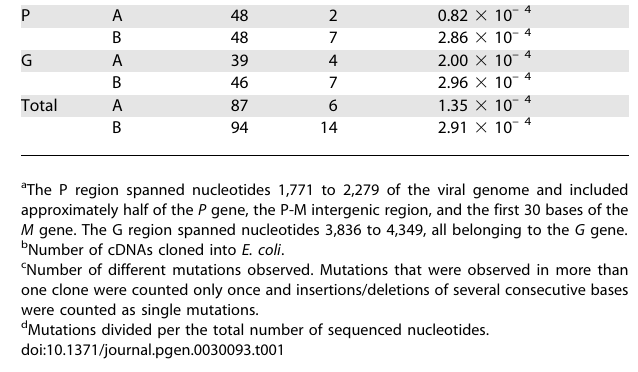
Figure 2. Observed Distribution of 1,000 Fitness Values for Populations A and B Based on Plaque Sizes Population A is shown in red and population B in blue. Mean log-fitness was 0.386 for population A, with variance 2.054. For population B, mean log-fitness was 0.498, with variance 0.225. Means were significantly different according to a Mann-Whitney test ( p , 0.001). A Kolmogorov- Smirnov test also showed that the two distributions were significantly different ( p , 0.001).